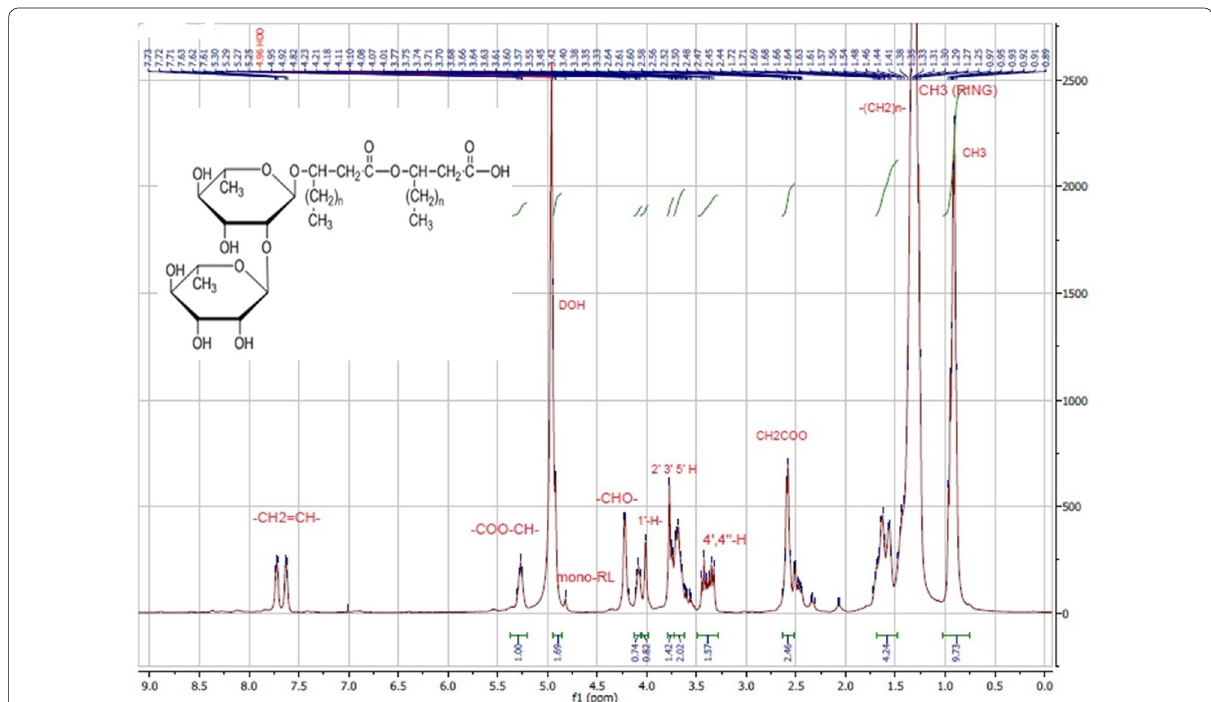
Fig. 1 1 H NMR spectrum of the RLs extracted from P. aeruginosa P6. At 4.8 ppm the small peak labelled mono‑RL is due to the rhamnose anomeric proton of mono‑RL species (Nicolo et al. 2017). The structure of the proposed RLs is shown over the spectrum